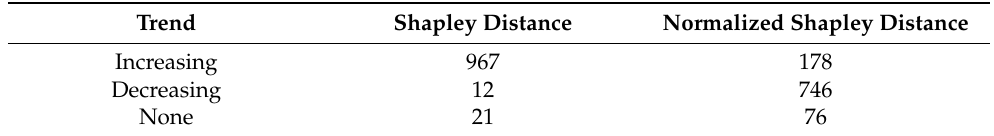
Table 3. Numbers of trials with increasing, decreasing, and no trend in the Shapley distance and normalized Shapley distance between day 20 and 100 with nucleolus. Trend Shapley Distance Normalized Shapley Distance Increasing 967 178 Decreasing 12 746 None 21 76